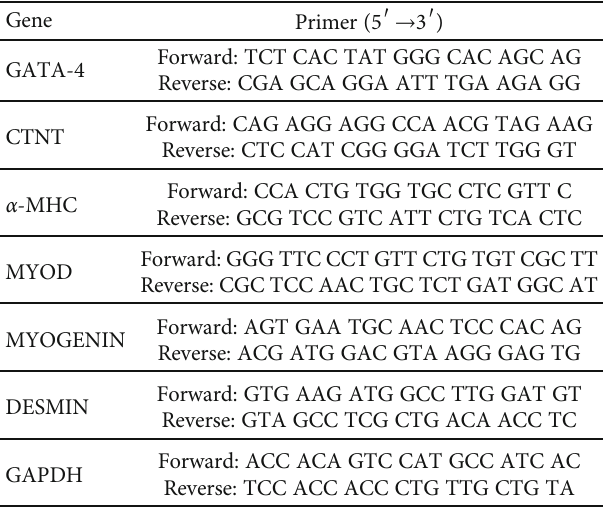
Figure 1: Reagent concentration and induction time point. Table 1: Primers used in this